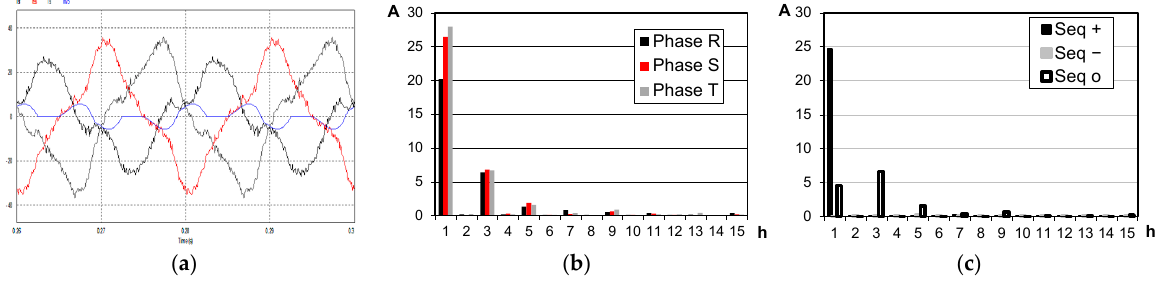
Figure 17. Case E - ( a ) supply currents (phases R , S , and T and neutral); ( b ) harmonic spectrum of phase components; ( c ) harmonic spectrum of the symmetric components.